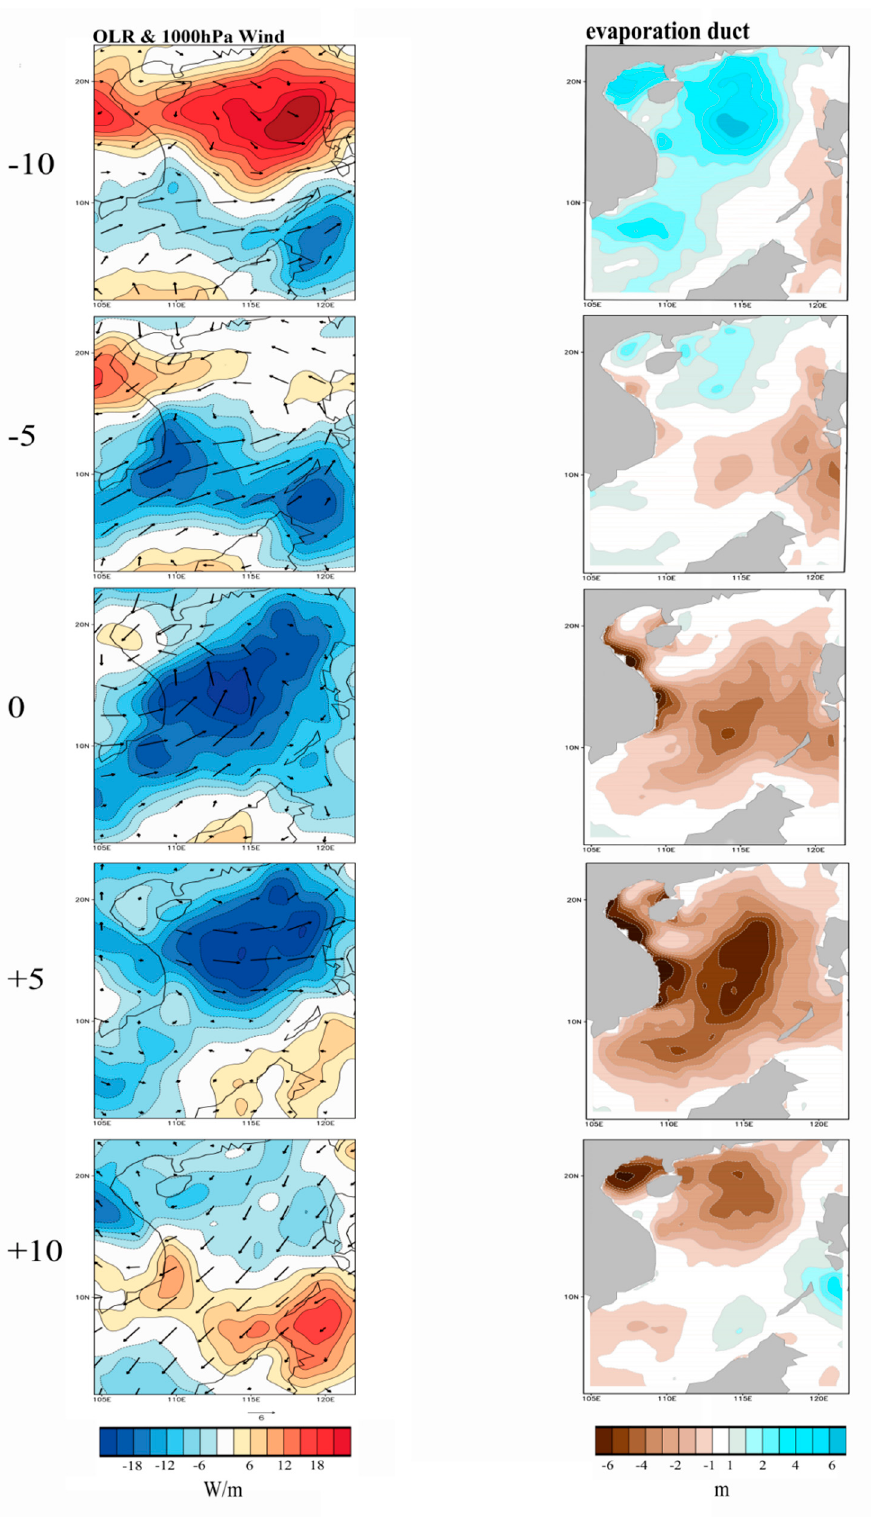
Figure 6. Composites of BSISO-related OLR anomalies, 1000 hPa horizontal wind vector ( left ), and evaporation duct ( right ) centered at days − 10, − 5, 0, + 5, and + 10, in terms of BSISO active events. Day 0 indicates the day at which deep convection of BSISO is maximized over the SCS, and positive (negative) days indicate the days after (before).